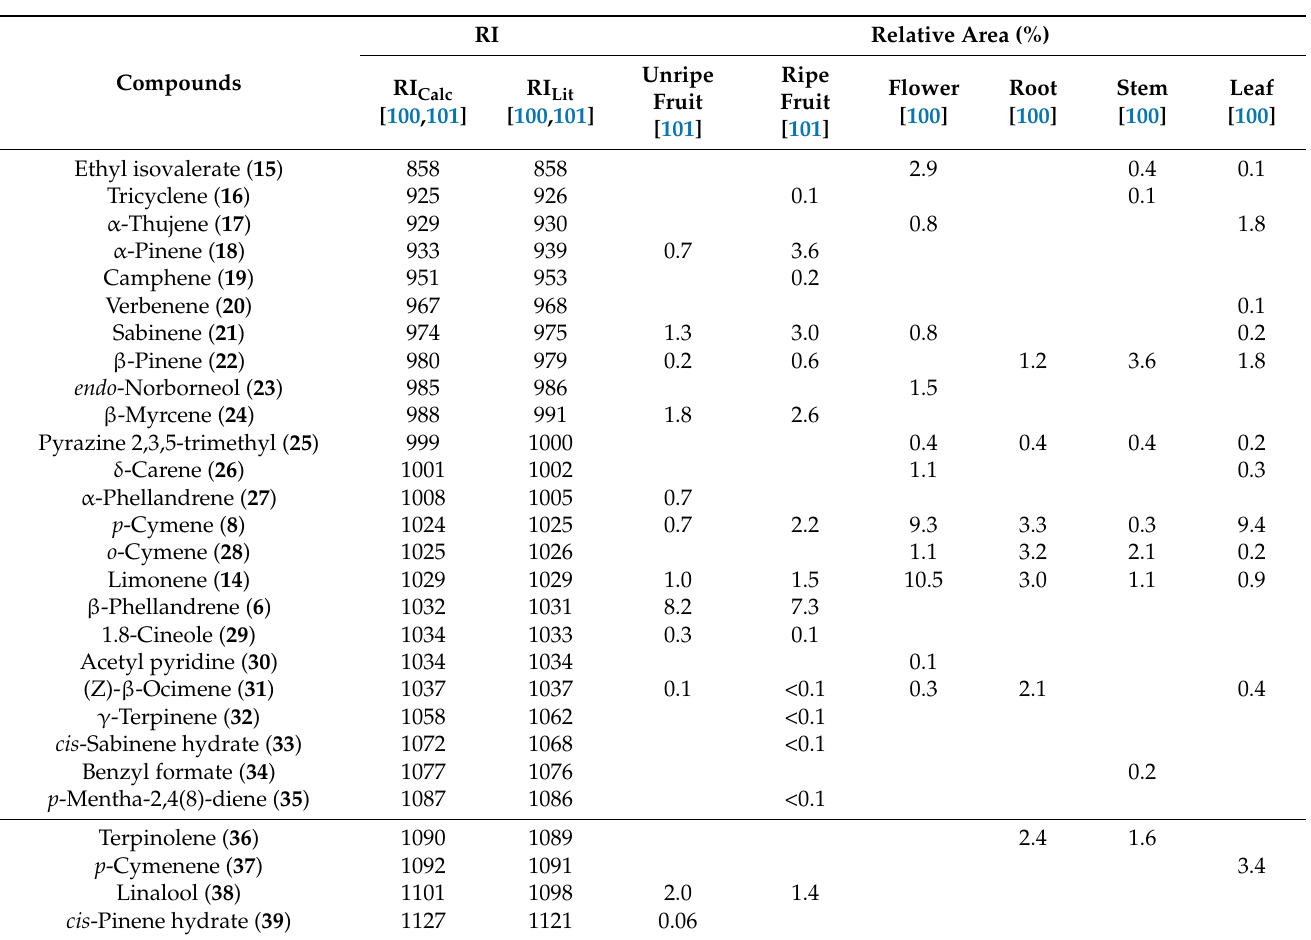
Table 1. The chemical compounds of P. amalago